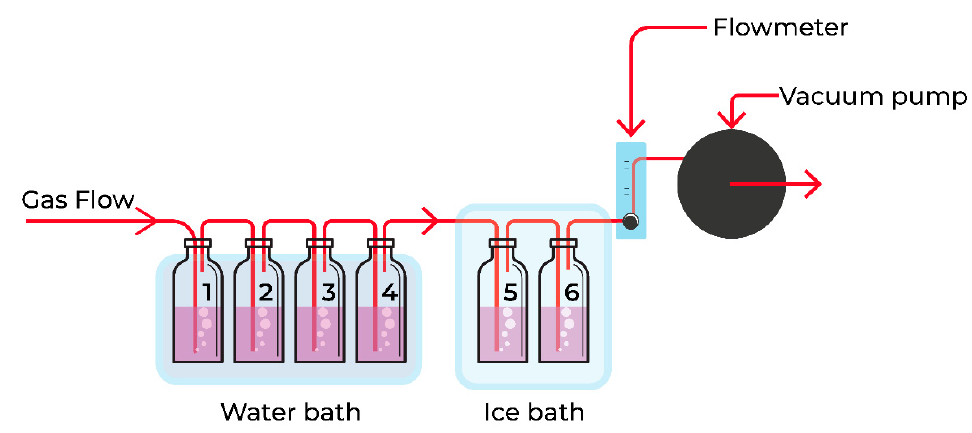
Figure 2. Sampling train schematic diagram.